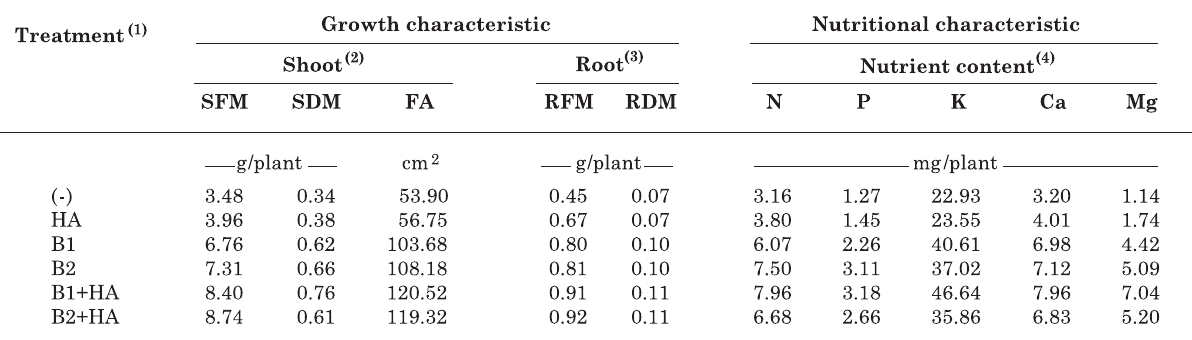
Table 2. Characteristics of shoot and root growth and nutrient accumulation in ‘Vitória’ pineapple plants in response to the application of humic acid and plant growth-promoting bacteria during